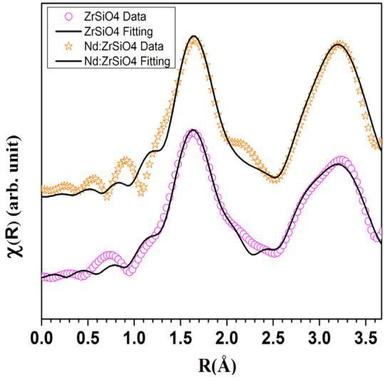
EXAFS data and fitting of pure and doped ZrSiO4.